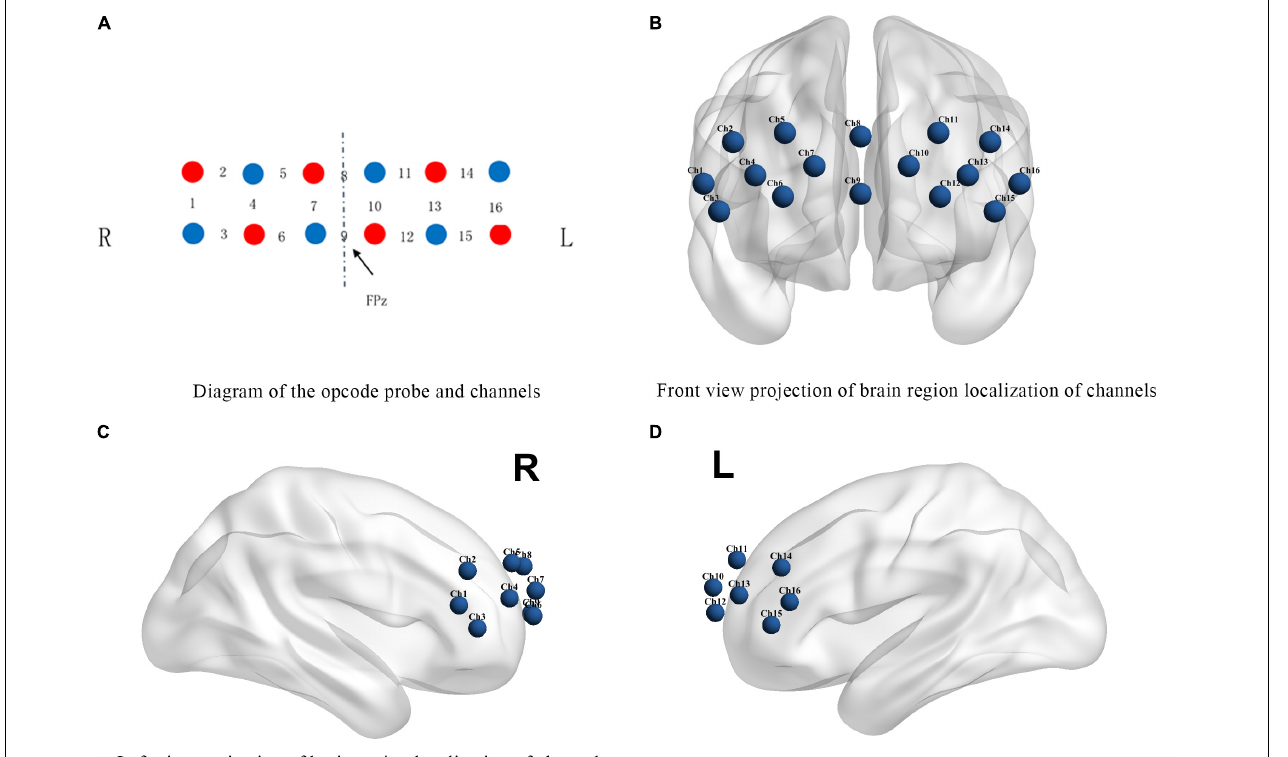
FIGURE 1 | Channel positions. (A) The red circles represent the light transmitting probes and the blue circles represent the light receiving probes. The numbers between probes indicate the signal channel numbers. R: right brain region; L: left brain region. (B–D) Show the projections of brain region localization of channels.